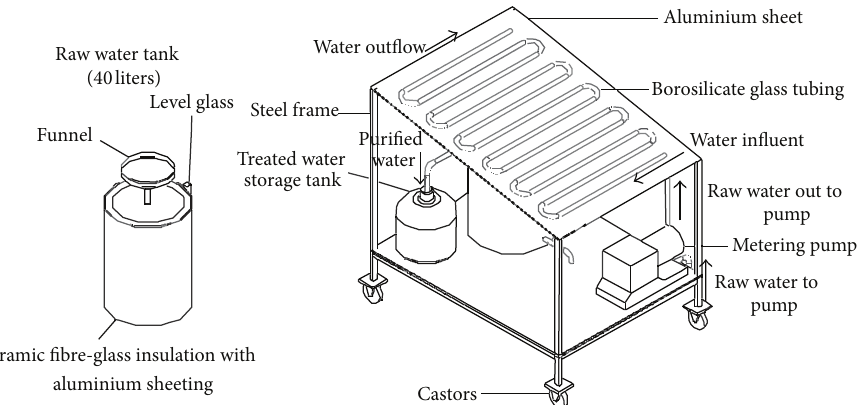
Figure 2: Schematic of non-concentrating, inclined flat-fixed bed solar photochemical reactor.